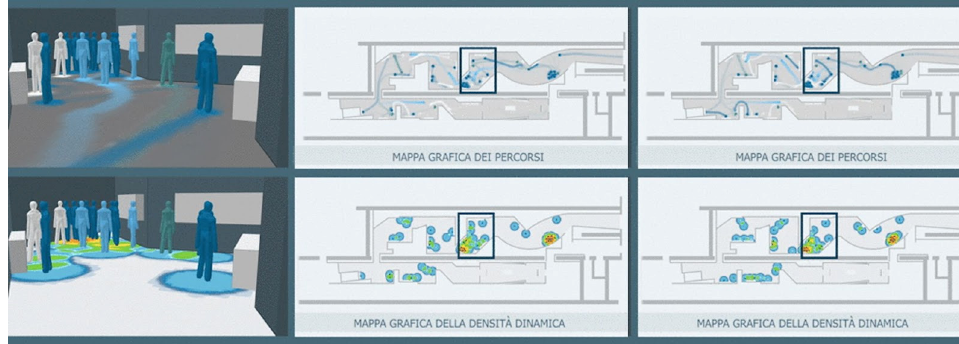
Figure 11. Simulation of different types of users in an exhibition space. On the first row, a graphic map of the paths; below, a graphic map of the dynamic density.